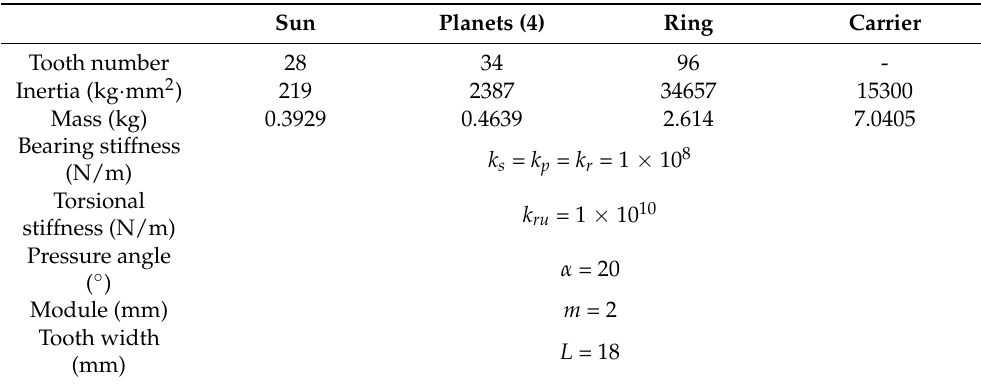
Table 1. Parameters of the planetary gear